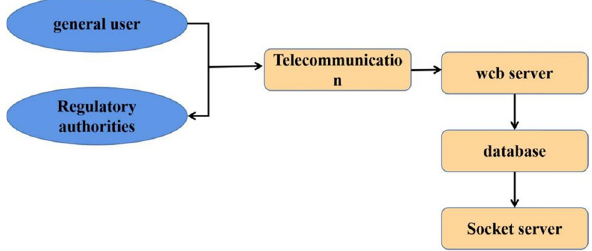
Figure 2: Software system structure